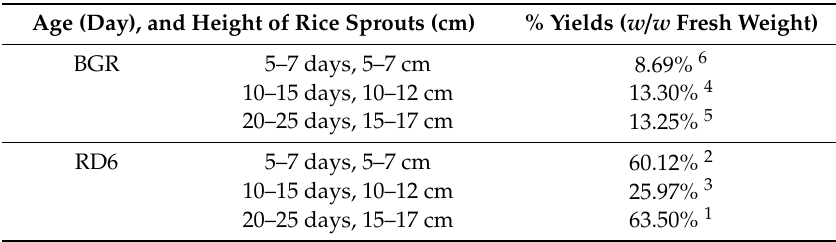
Superscript numbers from 1 to 6 assigned for high 1 to low 6 % extraction yield.